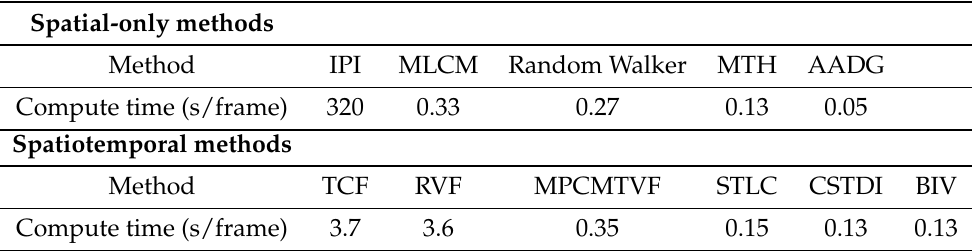
Table 2. Comparison of the compute time in seconds per frame (640 × 512